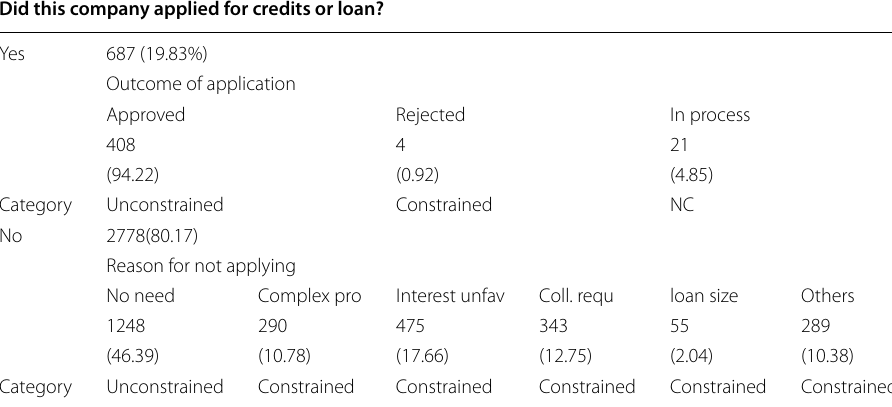
Table 9 Loan application and reasons for not